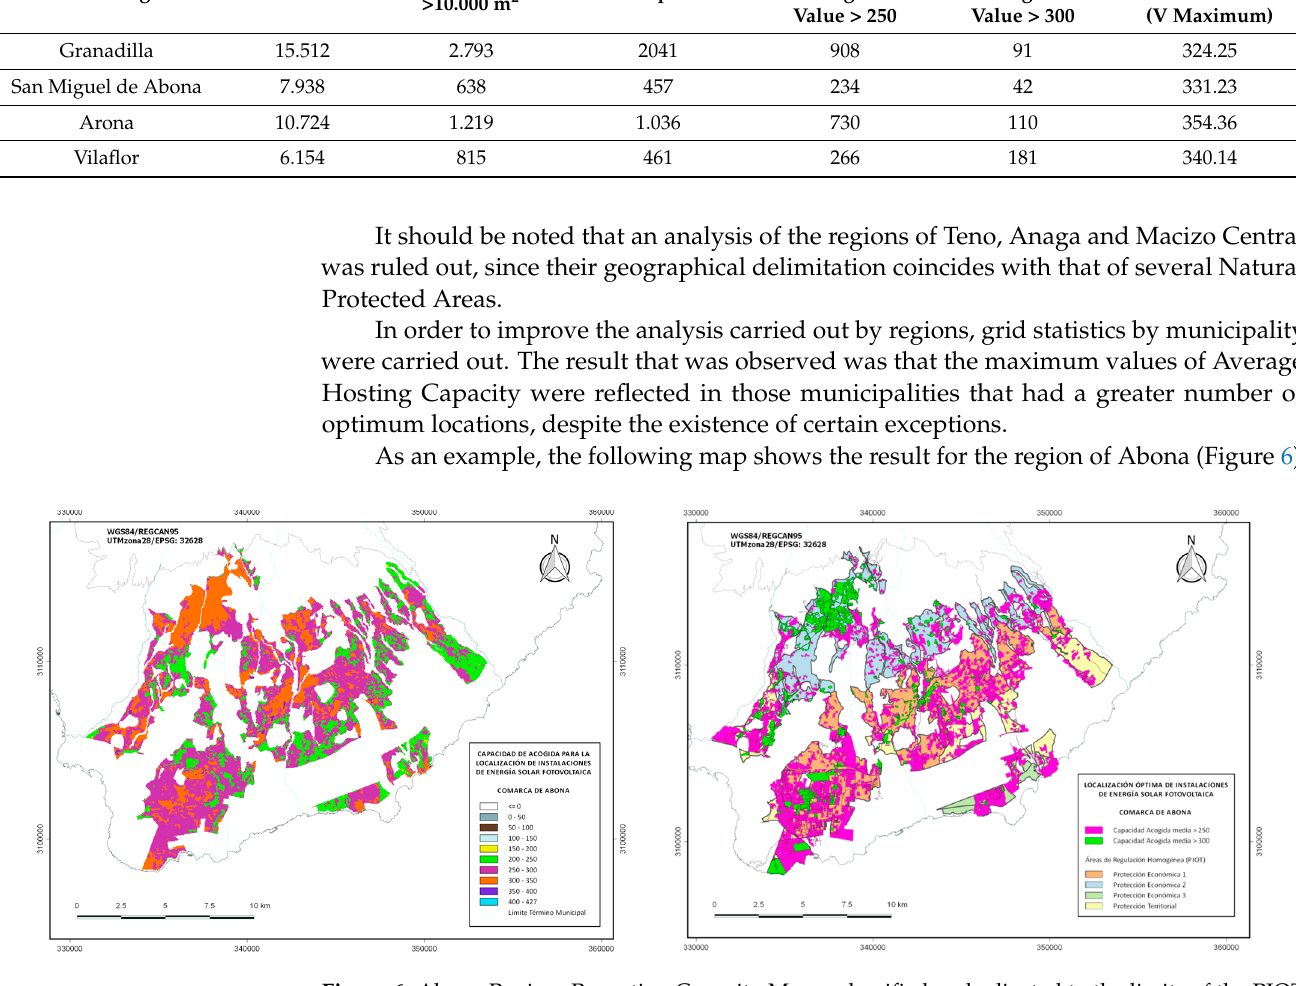
Figure 6. Abona Region: Reception Capacity Map reclassified and adjusted to the limits of the PIOT ARH ( left ); and Map of optimal locations for photovoltaic solar energy installations ( right ). With regard to the cadastral parcel that represents the best locations for this type of facility, and whose HC is at least 250 (parcels in green), the following map was obtained (Figure 7) for the region of Abona: